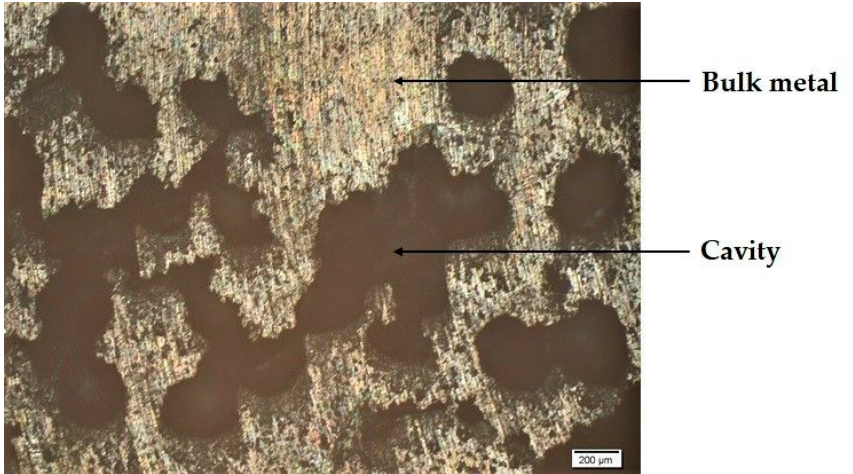
Figure 7. The macrostructure of a highly porous replicated Al foam obtained using a double-granular space holder. The space holder is a mix of SH 1 coarse, irregular granules and SH 4 fine, spherical granules.